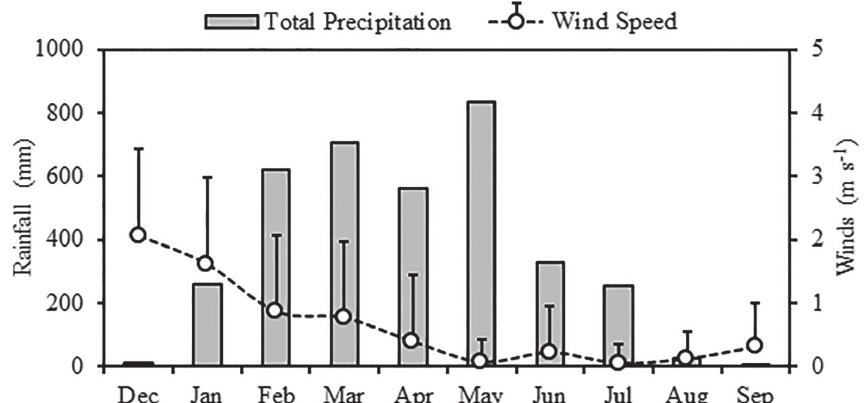
Figure 2 - Data of climatological variables during the period from December/08 to September/09: total rainfall (mm) and average wind speeds (m s -1 ) (+SD). Source: INMET (Weather Station located in the municipality of Bragança, Pará). vertical axes are plotted with different scales.